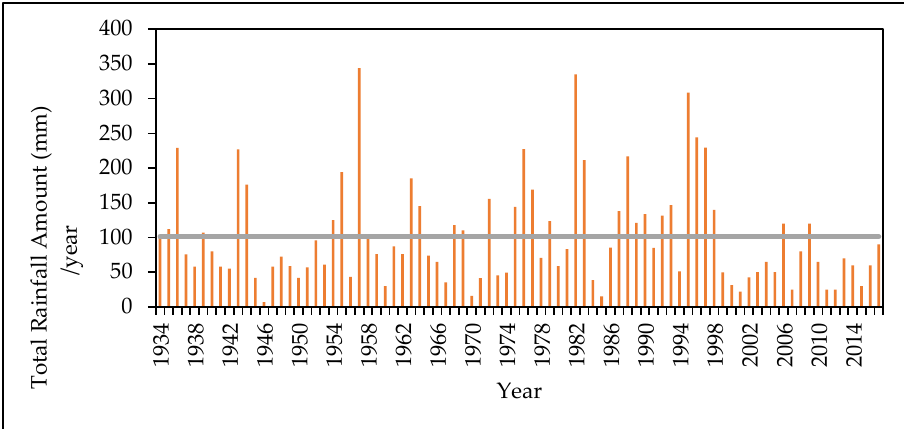
Figure 12. Total and average annual rainfall (mm).